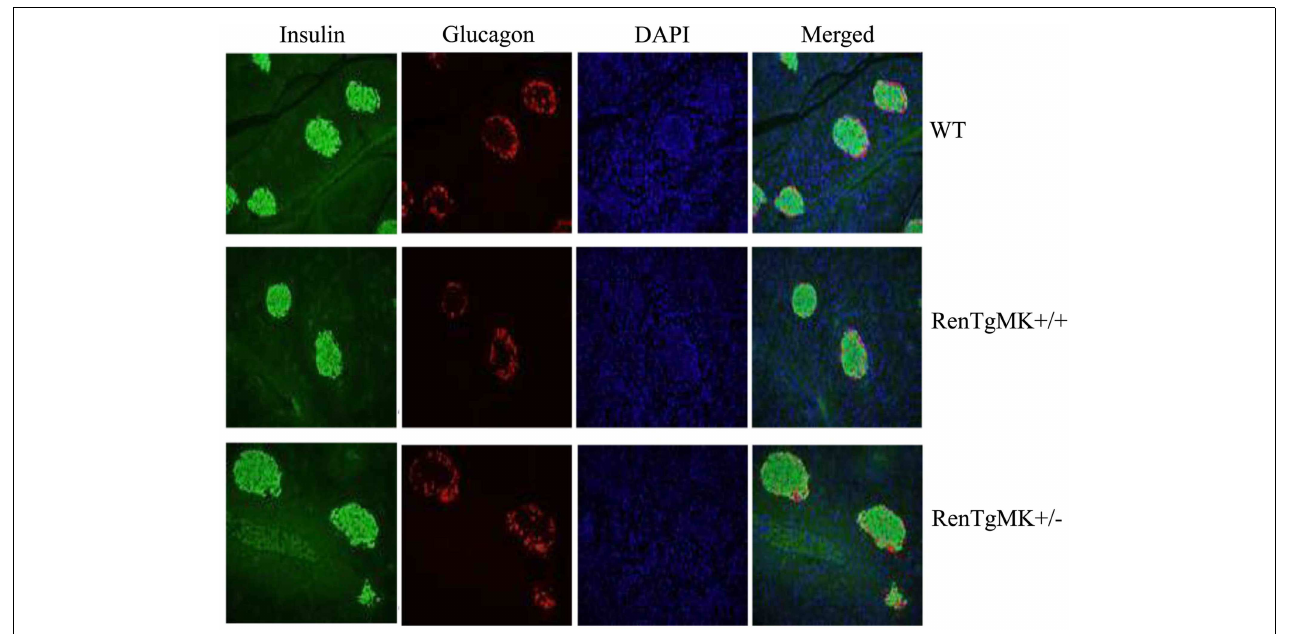
FIGURE 4 | Islet pathology. Pancreas histology and immunostaining were conducted to assess islet morphology and hormone content in male wild-type and RenTgMK mice, 20weeks of